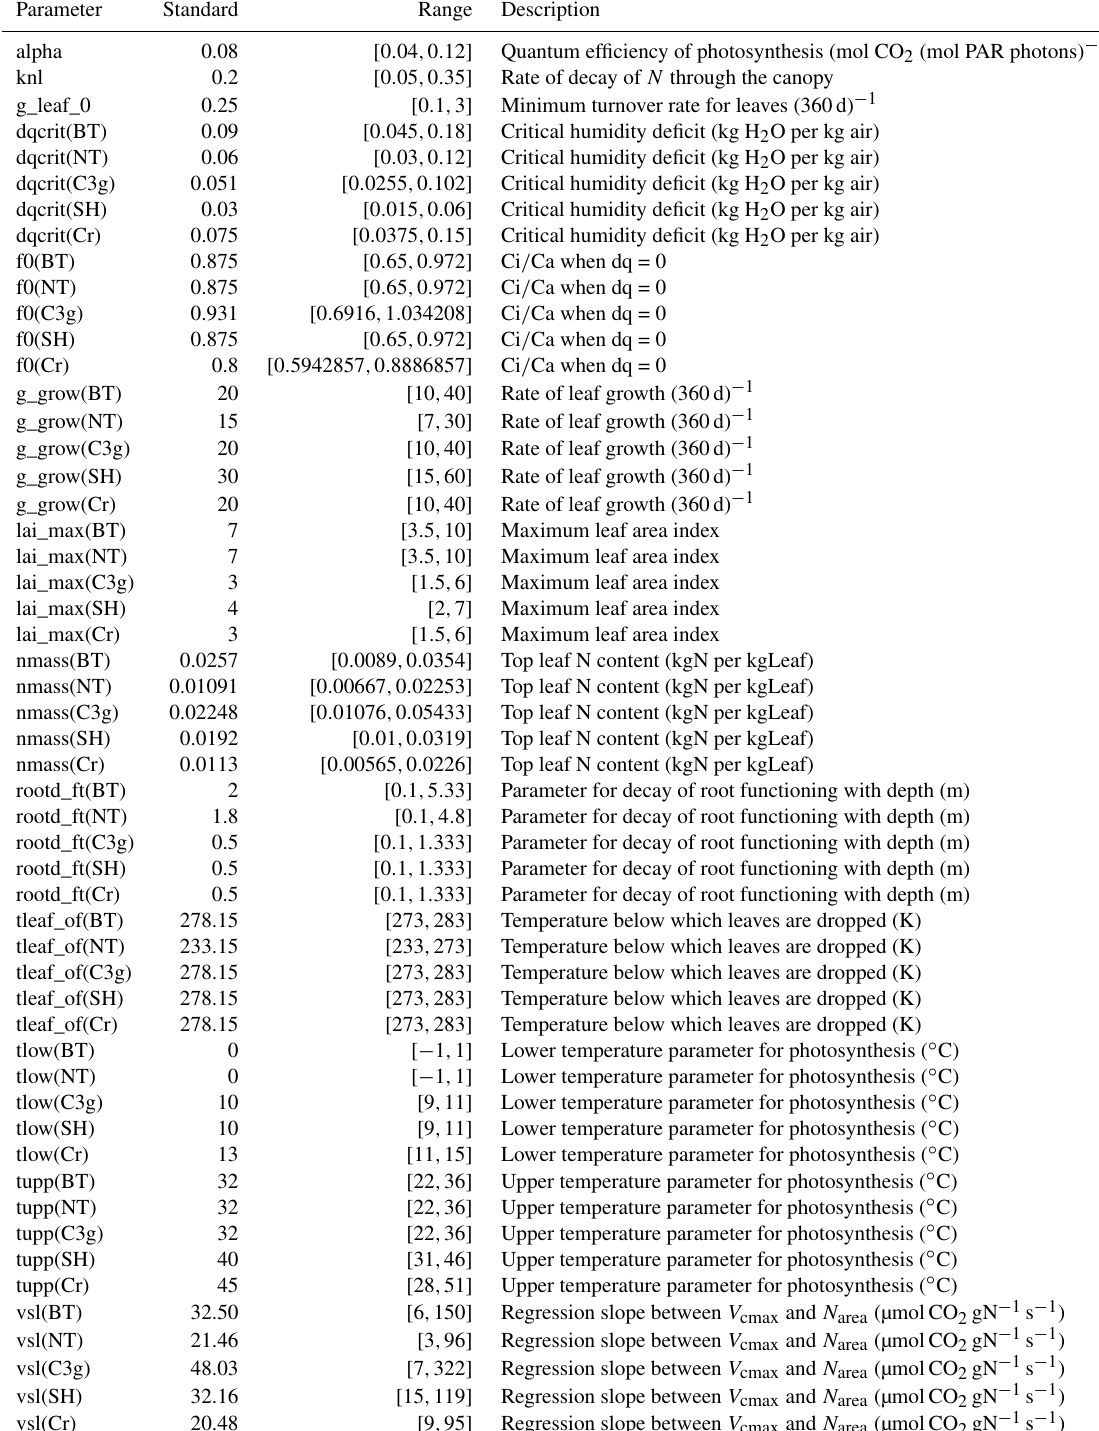
Table 1. A table showing the parameters, their “standard” values, their initial untuned ranges, and a short description. Most parameters are given different ranges for each plant functional type, indicated by the brackets in the parameter name, these are broadleaf trees (BT), needle-leaf trees (NT), C 3 grasses (C3g), shrubs (SH), and crops